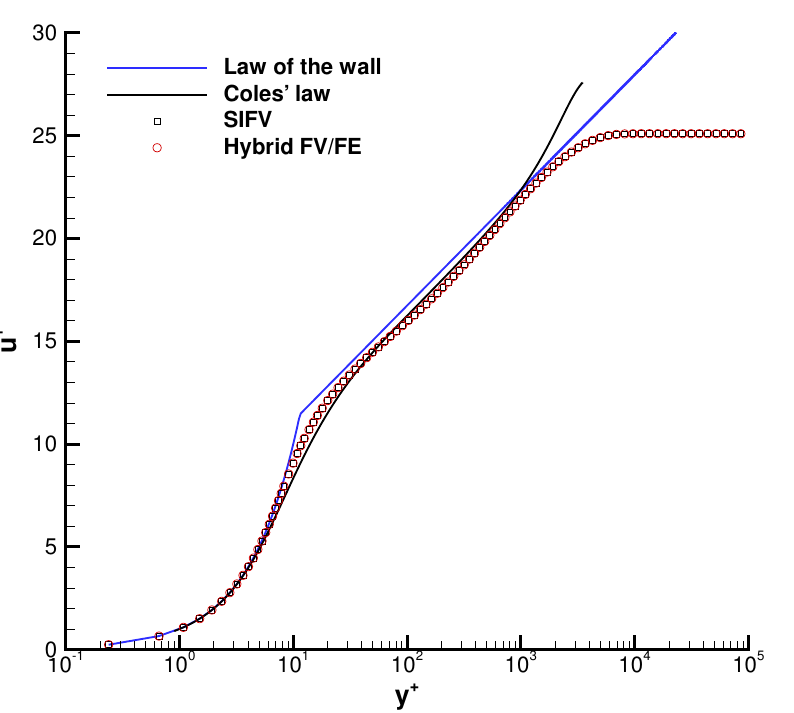
Figure 14. 1D cut through the turbulent boundary layer at time t = 10 at position x = 1.0. Profile of the velocity u + as a function of y + obtained with a semi-implicit finite volume scheme [9,12] applied to the incompressible Navier–Stokes equations and computational results obtained with the Cartesian hybrid FV/FE method presented in this paper. For comparison, we also provide the velocity profiles according to the usual law of the wall and the profile reported by Coles